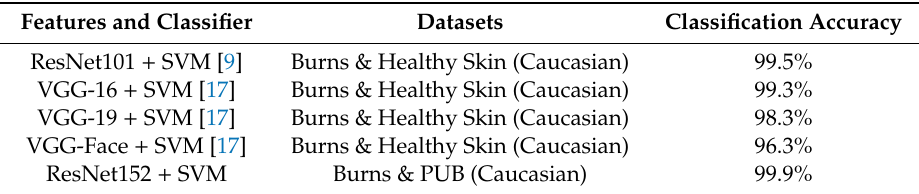
Table 6. Comparison with the state-of-the-art